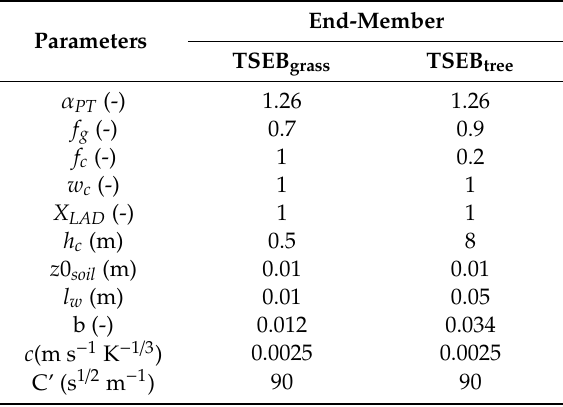
Table 4. TSEB gras s and TSEB tree model configurations based on global